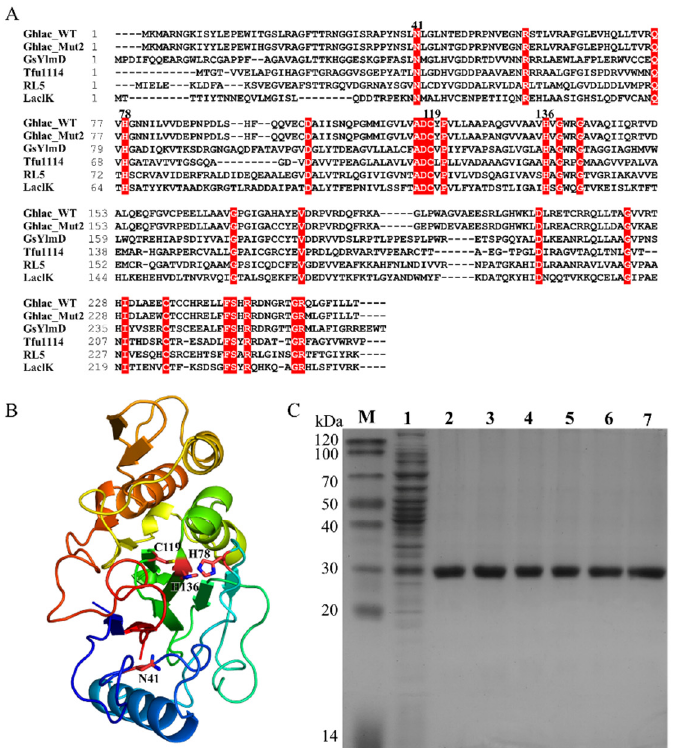
Figure 1. Structure analysis and purification of Ghlac. ( A ) The sequence alignment of Ghlac WT, Mut2, GsYlmD (WP_053413740.1), RL5 (CAK32504.1), Tfu1114 (AAZ55152.1), and LaclK (WP_029500662). The identical residues are highlighted in red. The putative residues binding with copper ions are labeled with the residue numbers. ( B ) Structural model of Ghlac based on GsYlmd (PDB: 6T0Y, https://www.rcsb.org/structure/6T0Y, accessed on 18 May 2020). The putative residues binding with copper ions are labeled. ( C ) SDS-PAGE analysis of Ghlac purified using Ni-NTA chromatography. Lane M: protein marker; lane 1: the supernatant of the homogenized cells expressing Ghlac WT; lane 2–7: the purified Ghlac WT, Mut2, H78A, C119A, H136A, and 3A, respectively.